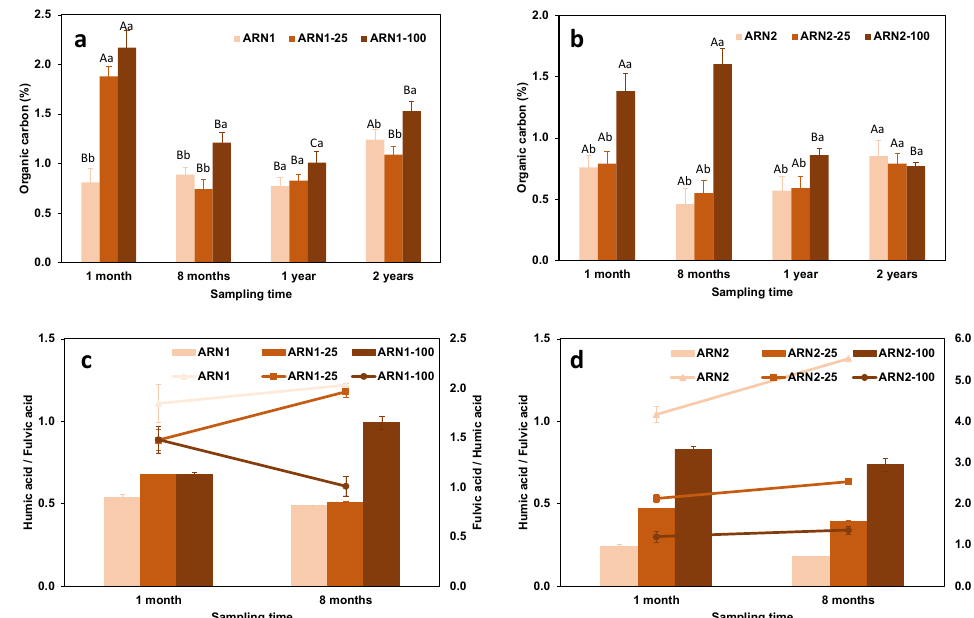
Figure 1 . Changes in the percentages of OC in ARN1 ( a ) and ARN2 ( b ), and HA/FA (bars) and FA/HA (lines) ratios for ARN1 ( c ) and ARN2 ( d ) soils, unamended and SMS-amended at two rates at different sampling times after SMS application. Error bars represent the standard deviation of the mean. Different lower-case letters above the bars denote significant differences ( p ≤ 0.05) between samples at each sampling time, and different upper-case letters above the bars denote significant differences ( p ≤ 0.05) for each sample at different sampling times.